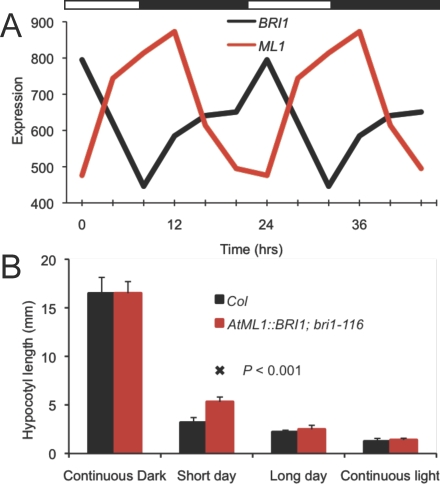
Time-of-Day–Specific Expression of BRI1 Is An Important Factor for Proper Hypocotyl Growth(A) The phase of ML1 expression (black) is 12 h later than the phase of BRI1 expression under short-day photocycles. Black bars above graph represent dark period of the day.(B) Proper photoperiodic hypocotyl elongation requires correct phasing of the BR perception. AtML1::BRI1, bri1-116 (red bar) has longer hypocotyls under short-day photoperiods [37], compared to Col (black bar); p < 0.001, Student t-test. Plants were grown for 7 d under four different light conditions: continuous light, short days (8-h light/16-h dark), long days (16-h light/8-h dark), and continuous dark. All data represent the results from two independent experiments.